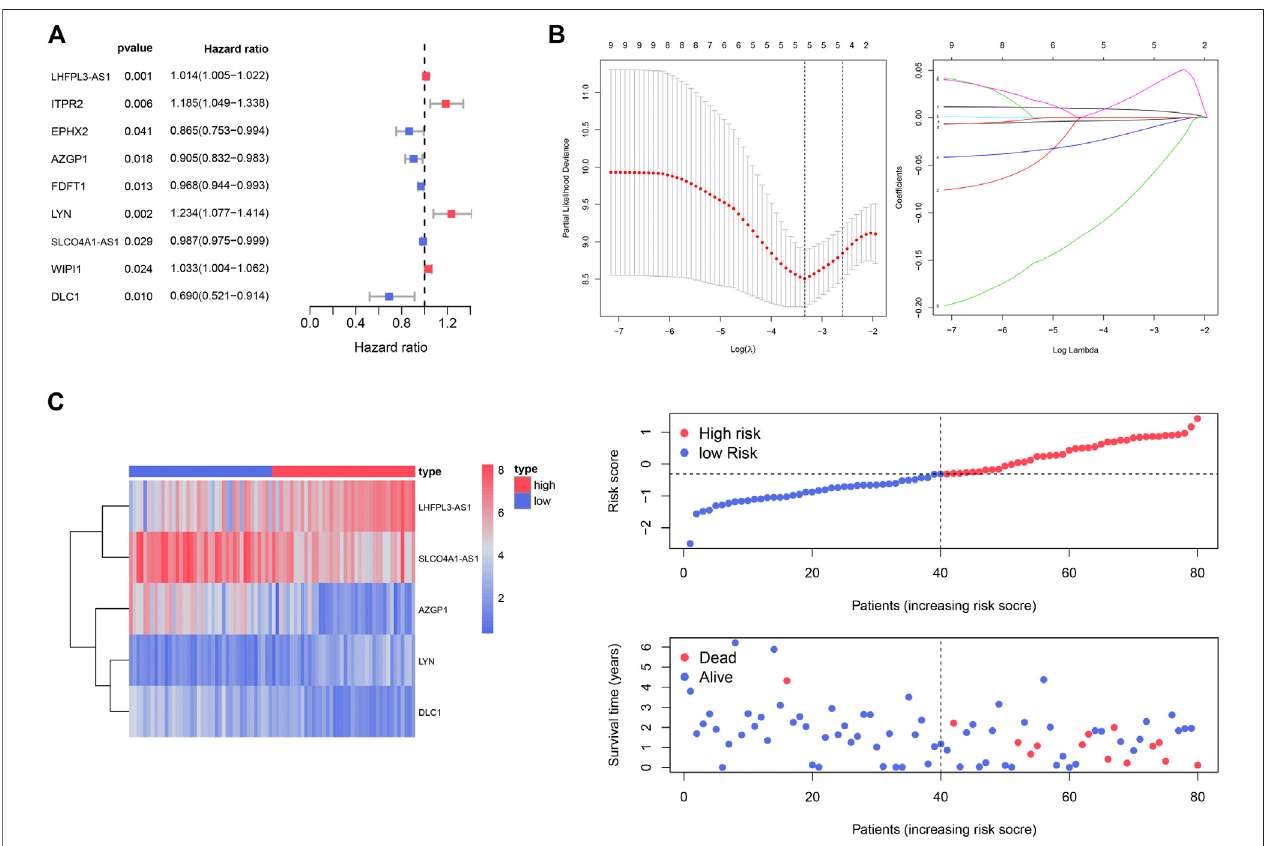
FIGURE5| Identi fi cationoftheprognosticgenesignatureforUVMpatientsintheTCGA_UVMset. (A) Atotalofninegeneswereidenti fi edassurvival-relatedgenes ( p < 0.05) using univariate Cox regression. (B) A prognostic model was established with fi ve genes to predict the OS of UVM patients using LASSO multivariate Cox analysis. (C) UVM patients were divided into low- and high-risk subgroups based on the median cutoff risk score: the heatmap of gene expression, distribution of risk score and survival status between the two groups.